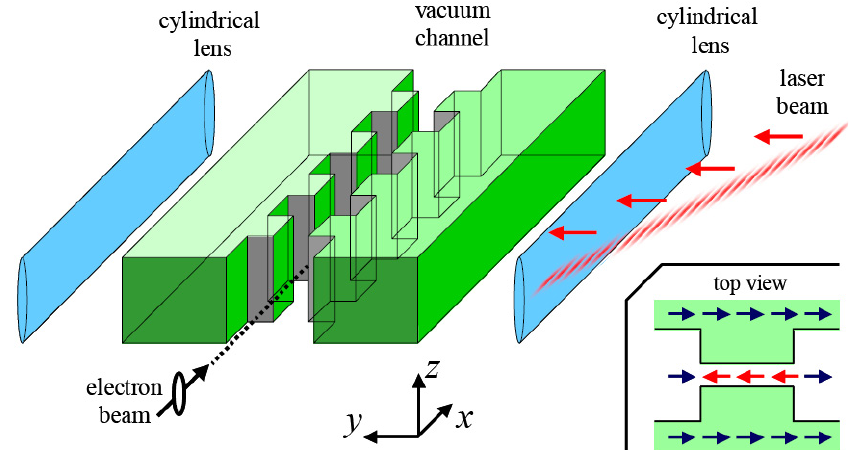
FIG. 1. (Color) Perspective view of the proposed accelerator structure. The incoming electromagnetic wave suffers a periodic phase inversion as it enters the vacuum channel. The inset shows the electric field modulation in the vacuum channel region. As the electromagnetic wave exits the vacuum channel, it experiences an additional periodic phase modulation that largely reconstructs the initial profile of the incoming